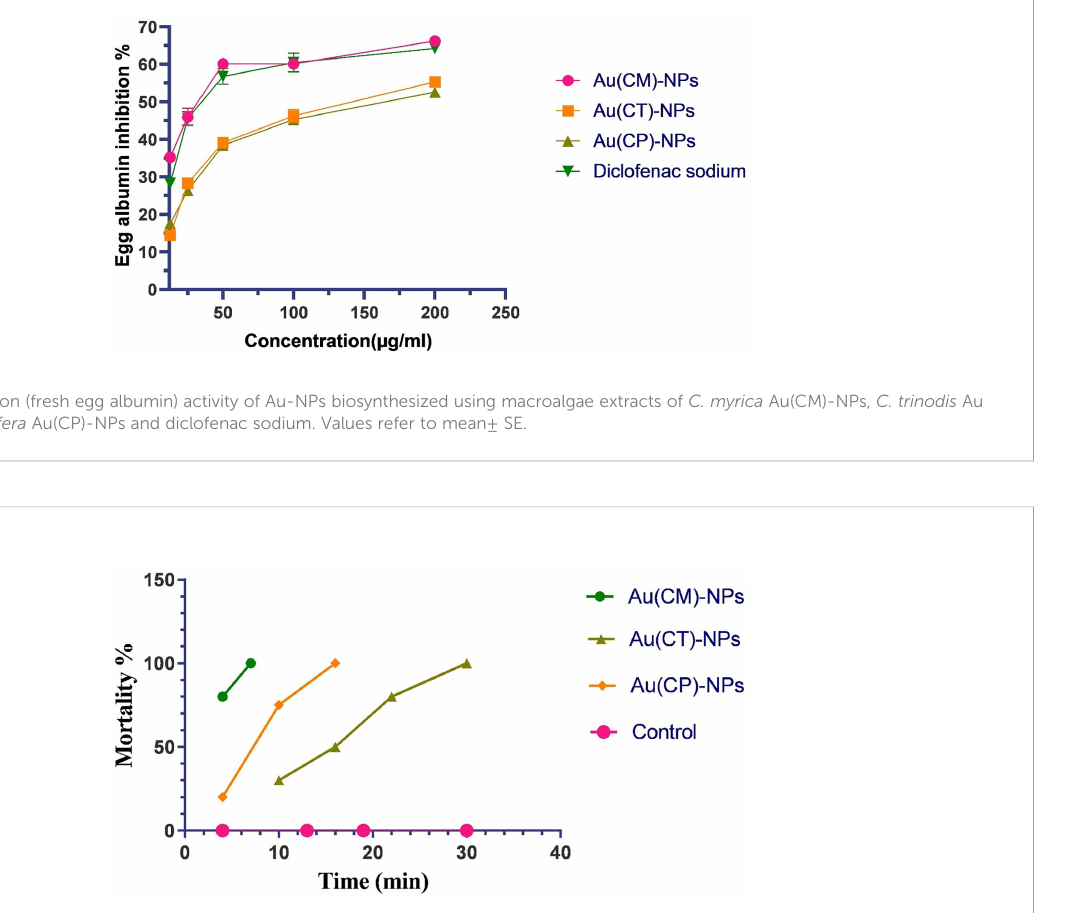
FIGURE 10 Cercaricidal activity of Au-NPs biosynthesized using extracts of macroalgae C. myrica Au(CM)-NPs, C. trinodis Au(CT)-NPs, and C. prolifera Au (CP)-NPs against S. mansoni